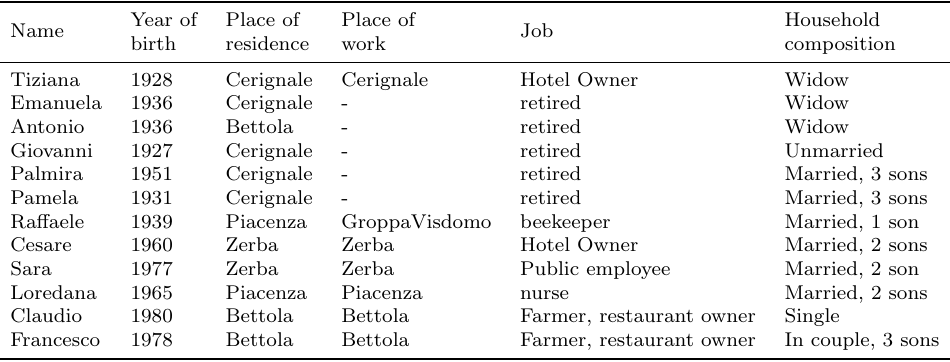
Table 1: The interviewees: age, place of residence and work, type of work and household